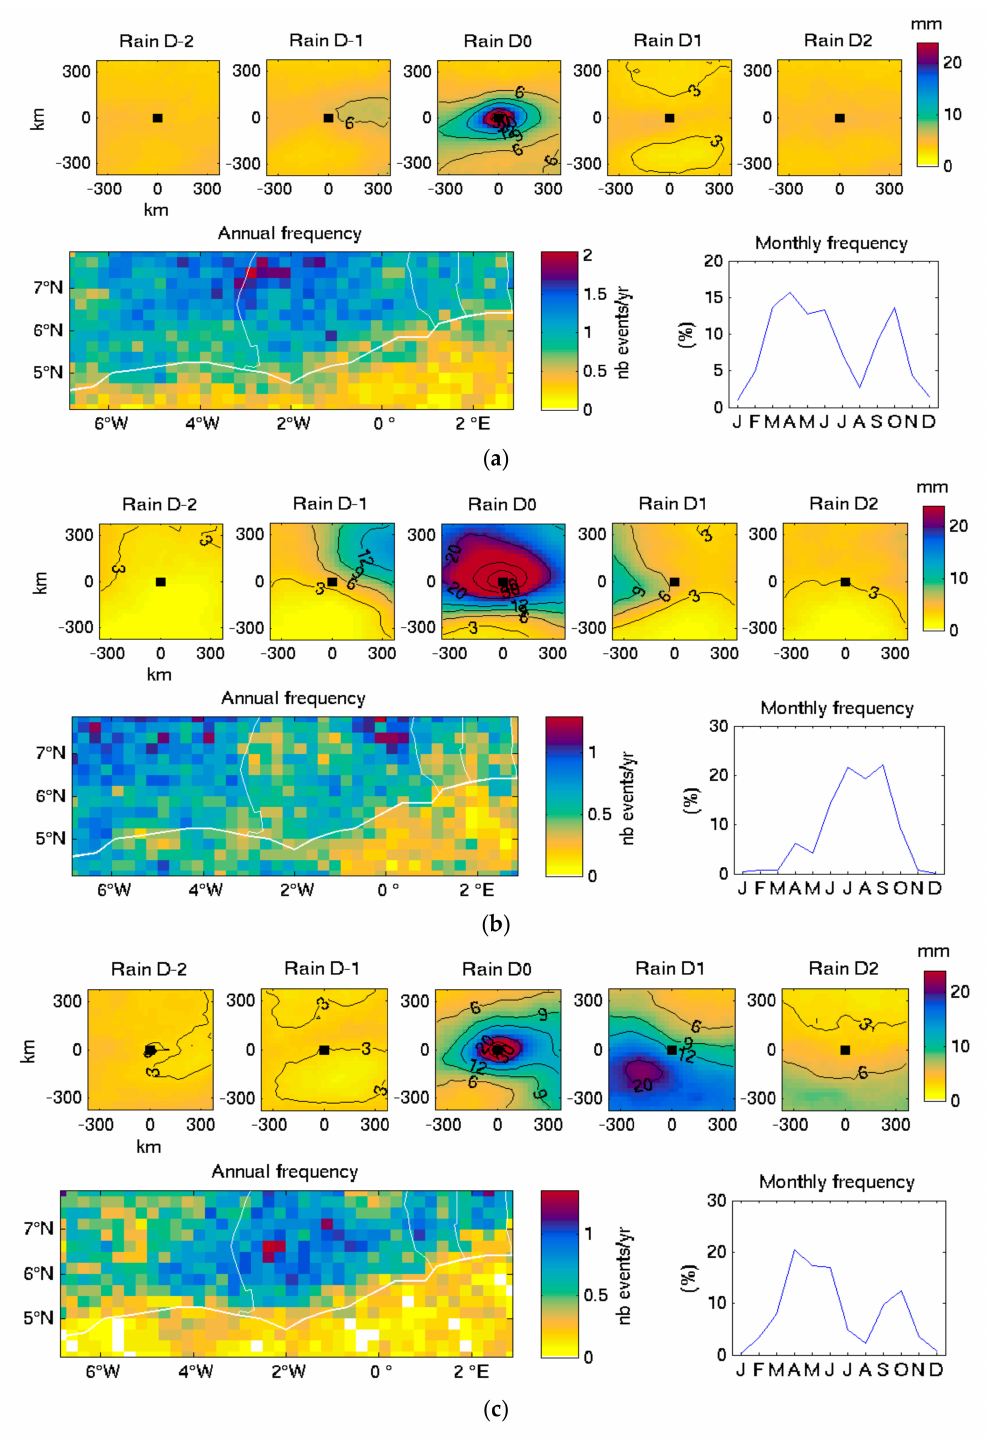
Figure 10. Sub-types ( a ) 1A, ( b ) 1B, and ( c ) 1C of daily rainfall distribution patterns associated with cluster 1 (mainly land areas). Small panels: rainfall maps centered on the grid-point where the event occurs (black square), for each day of the 5-day sequence (2 days before to 2 days after the event). Larger panels: geographical distribution of the number of intense events pertaining to each subtype and monthly frequency of each